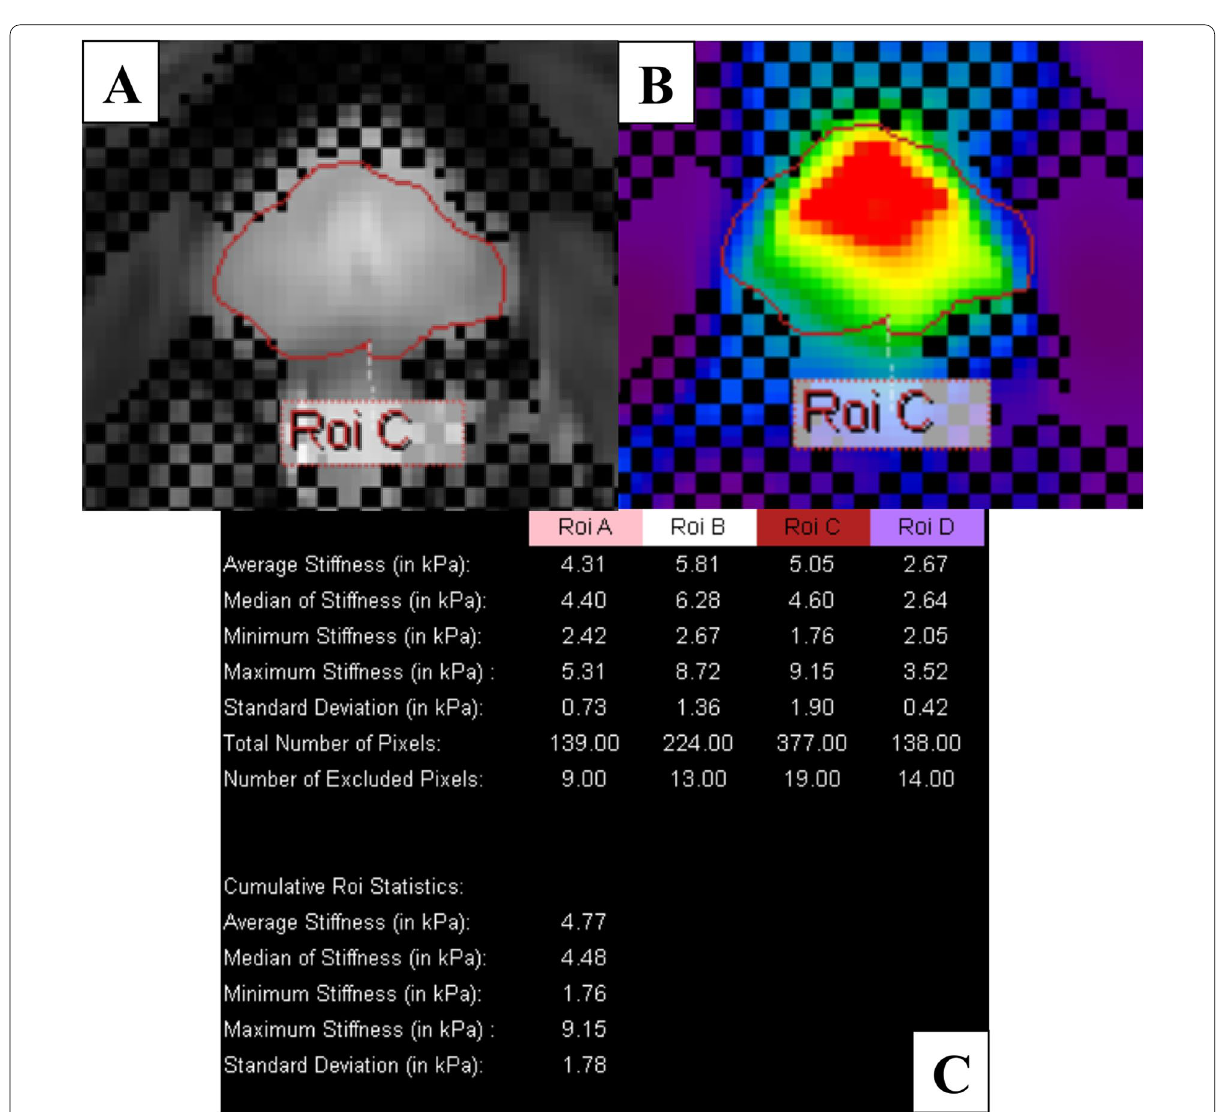
Fig. 2 Demonstrating the measurement method and documented results in post-processing software. A The ROI was drawn manually covering the entire prostate gland on the axial image. B ROI was also shown on the stiffness image. C Displayed stiffness values in each slice in average, median, minimum, maximum, and SD of stiffness with aggregate stiffness values